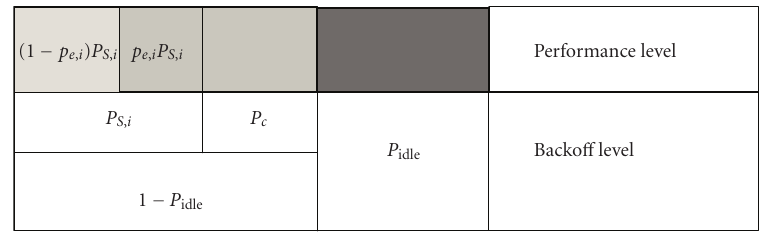
Figure 4: Probability spaces in the analysis of 802.11 standards for error